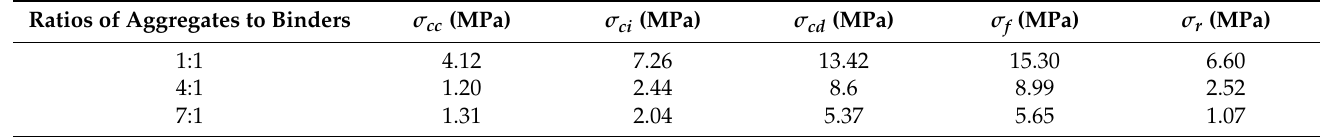
Table 5. Characteristic stress values of the stress–strain